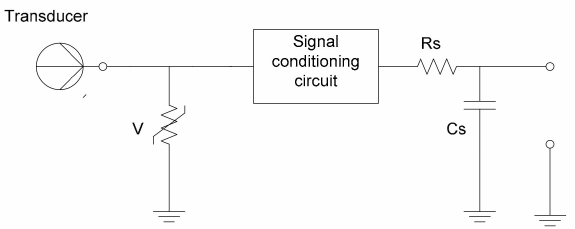
Figure 4. Passive protection using a mixture of a varistor and passive RC protective